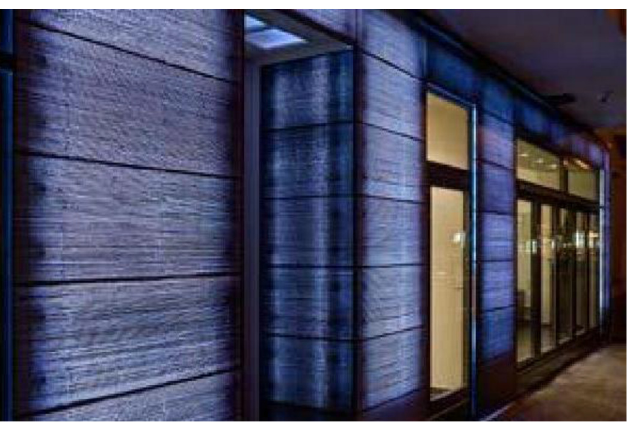
Figure 4. Characteristic applications of LTC [2,35].